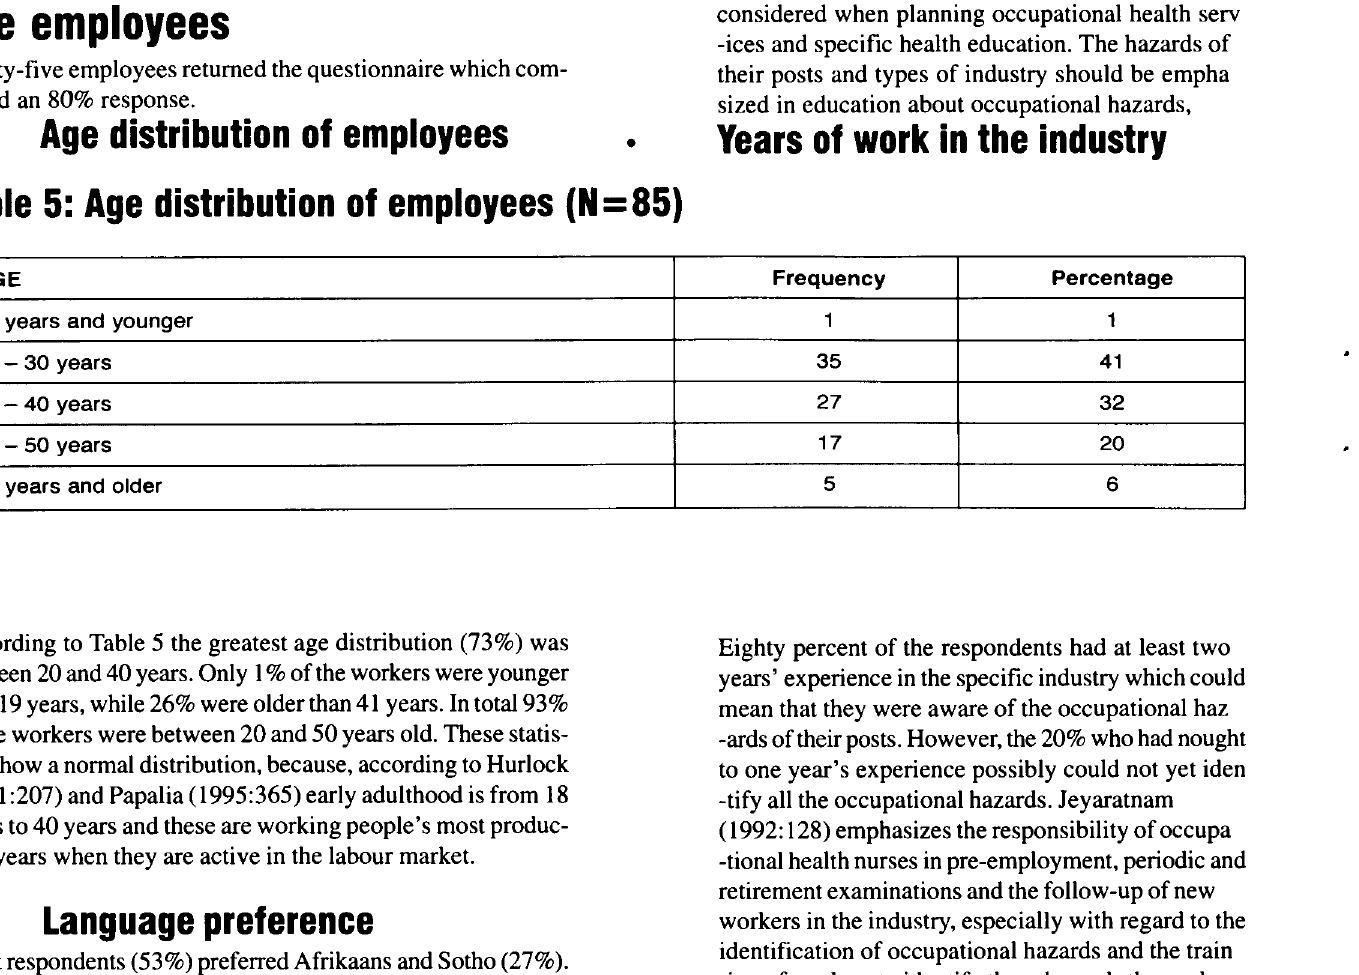
Table 5: Age distribution of employees (N=85)